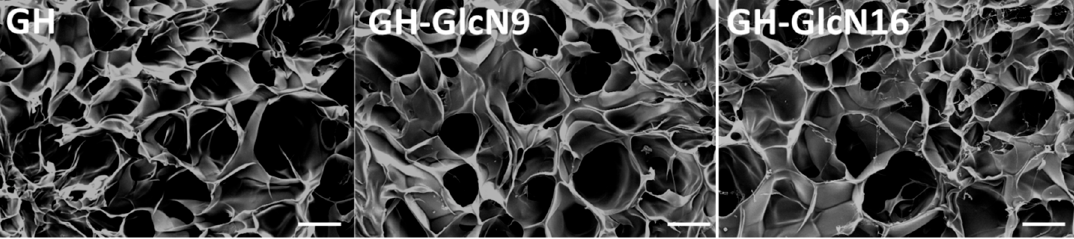
Figure 1. Scanning electron micrographs of GH, GH-GlcN9 and GH-GlcN16 cryogel scaffolds. GH: gelatin/hyaluronic acid cryogel; GH-GlcN9: gelatin/hyaluronic acid/glucosamine cryogel with 9% glucosamine; GH-GlcN16: gelatin/hyaluronic acid/glucosamine cryogel with 16% glucosamine. Scale bar = 100 μ m. Table 1. Properties of cryogel scaffolds. Values are mean ± standard deviation (SD) of six independent measurements.